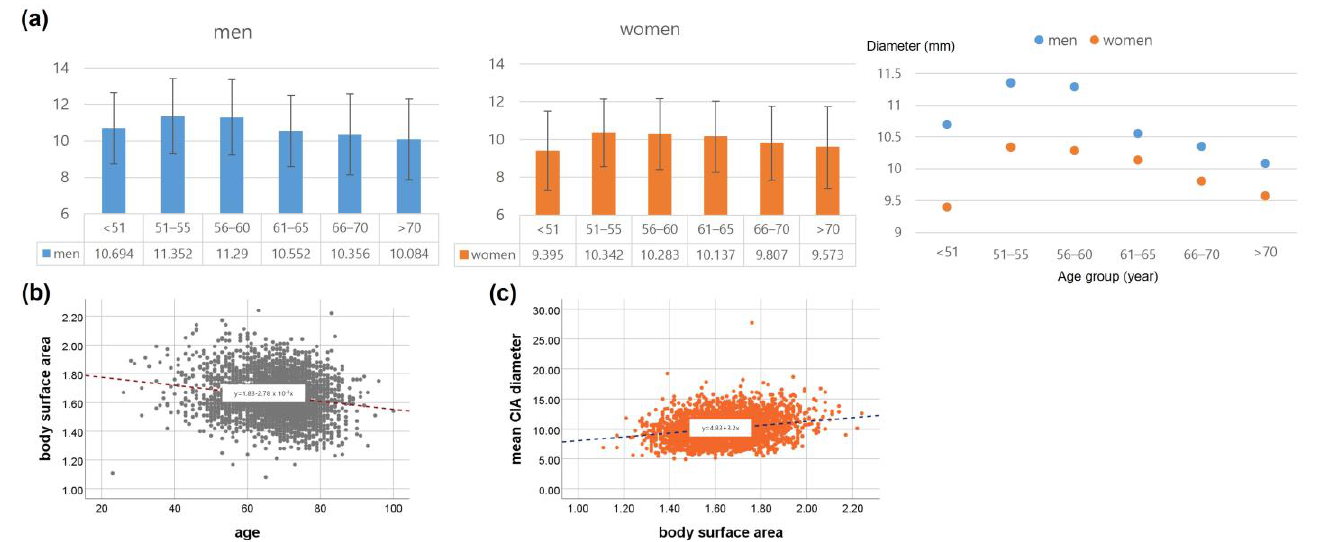
Figure 2. Distribution of the diameters of the common iliac arteries (CIAs) in the Korean cohort: ( a ) diameters of the CIAs of men and women; ( b ) Relationship between age and mean CIA diameter; ( c ) Relationship between body surface area and mean CIA diameter.